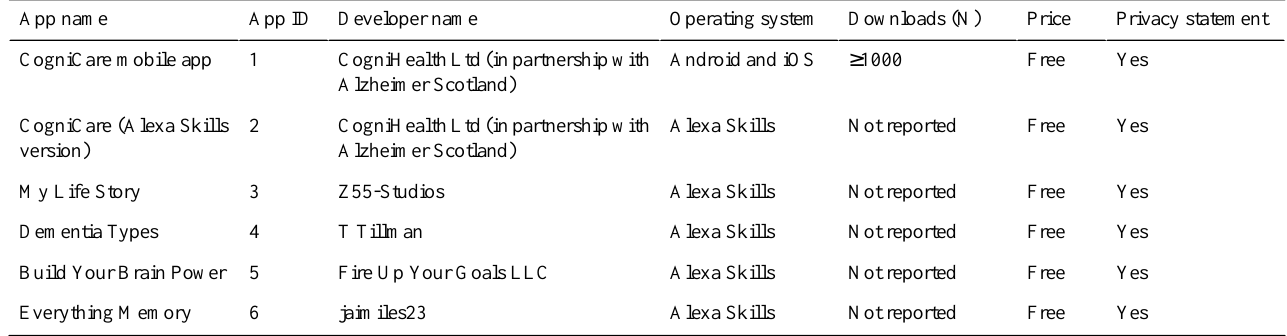
Table 1. General information about the chatbot